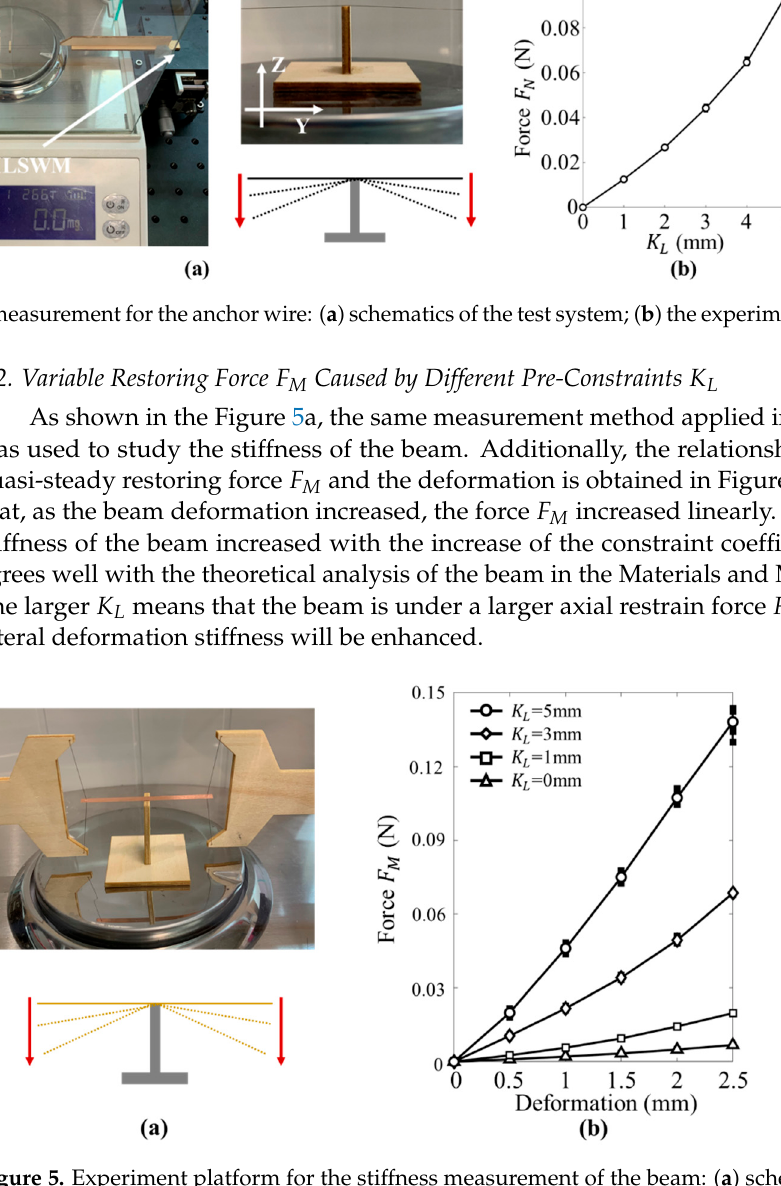
Figure 5. Experiment platform for the stiffness measurement of the beam: ( a ) schematics of the test system; ( b ) the experimental